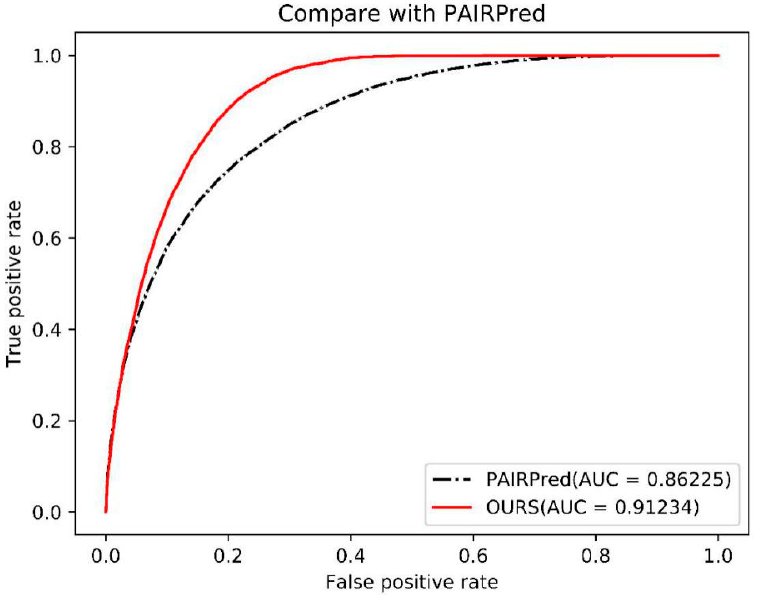
Figure 3. Compare with PAIRPred using AUC.